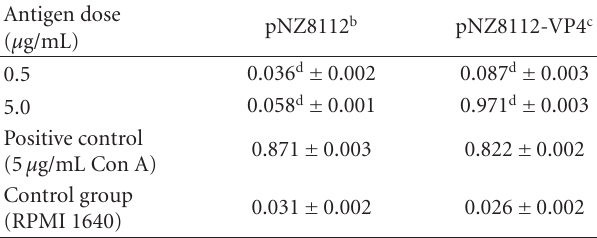
Table 1: Spleen cell proliferation to VP4 in immunized mic e a